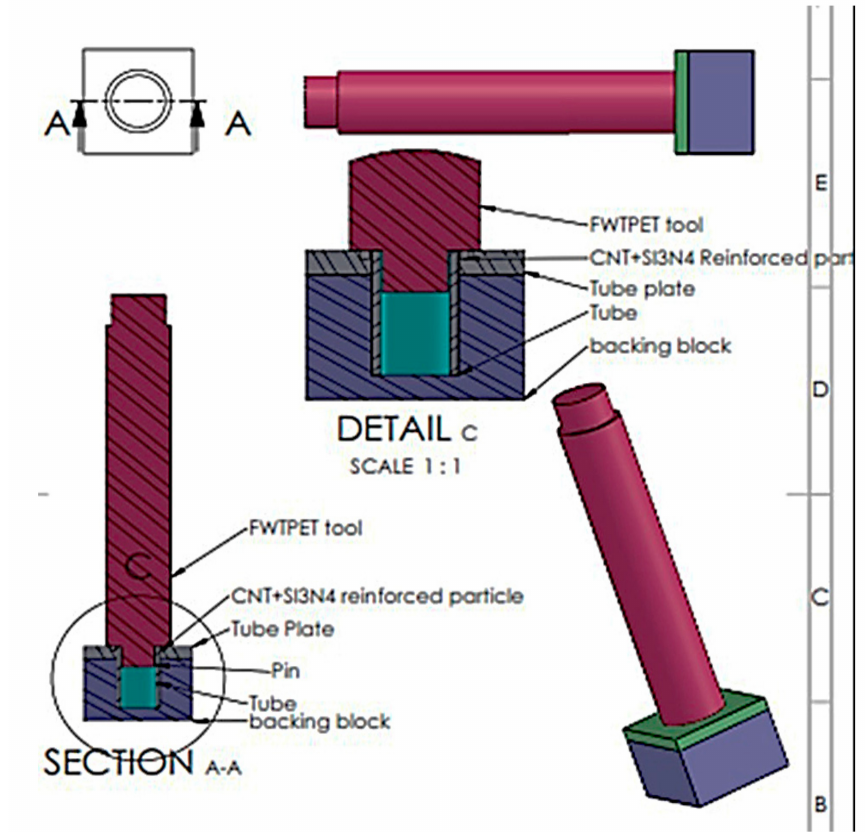
Figure 4. Schematic diagram—FWTPET + FSP arrangement of the tube to tube plate weld